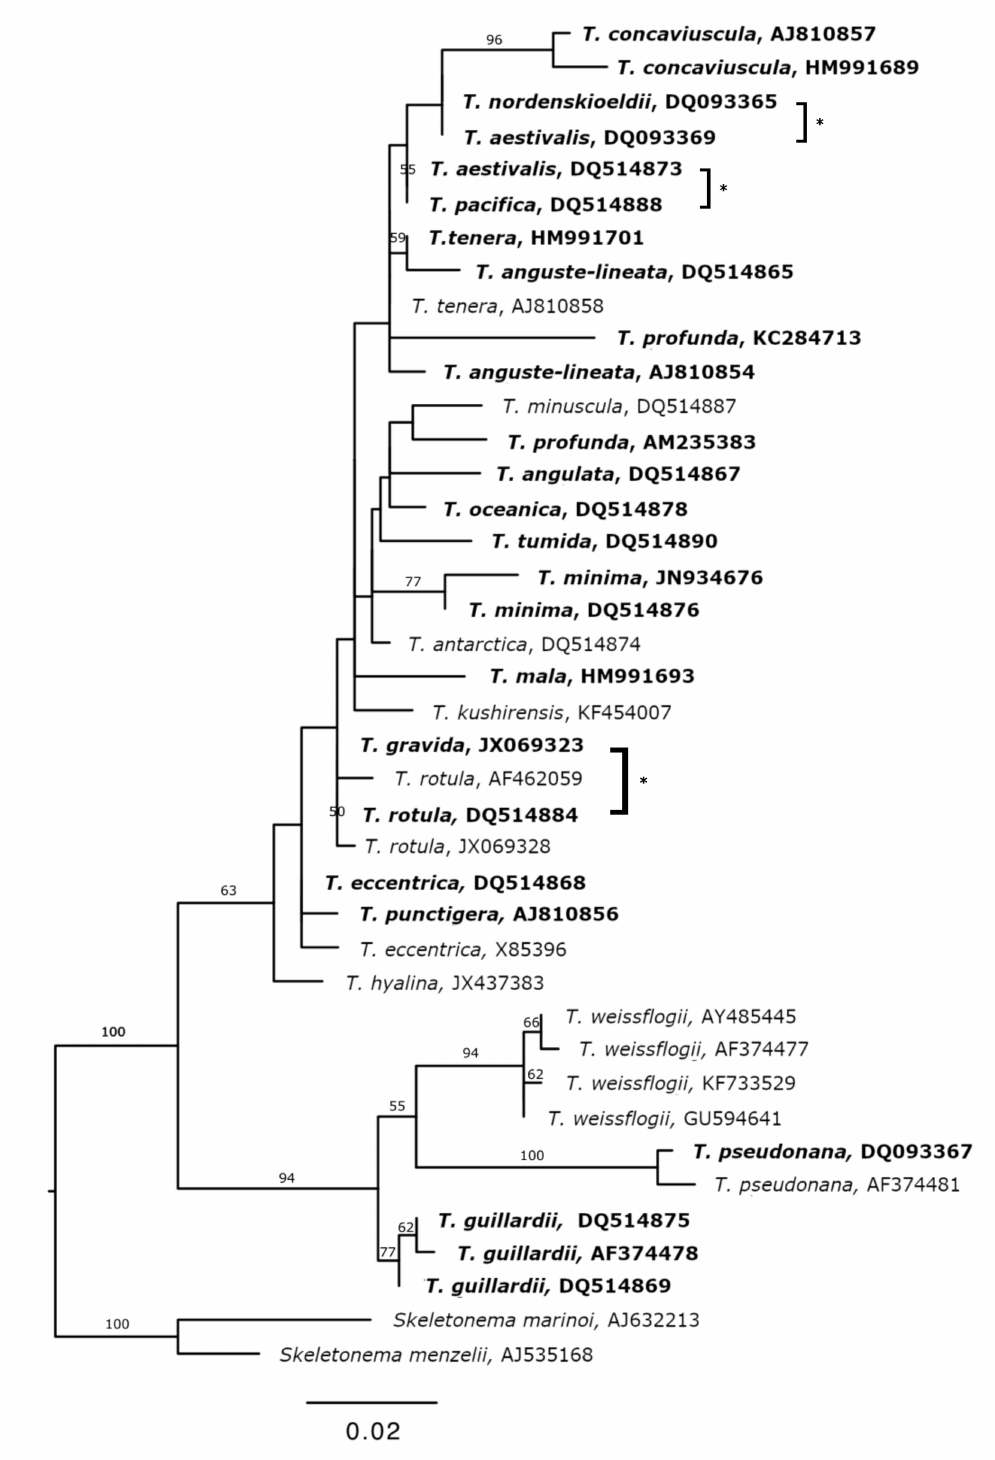
Figure 2. A maximum likelihood tree of Thalassiosira 18S V4 sequences included in the custom reference database. Bootstrap values ( > 50) are given at the nodes. Scale bar indicates genetic distance in substitutions per site. Bold labels denote sequences identified in the field samples analyzed here. Brackets with asterisks denote di ff erent species that are indistinguishable at the V4